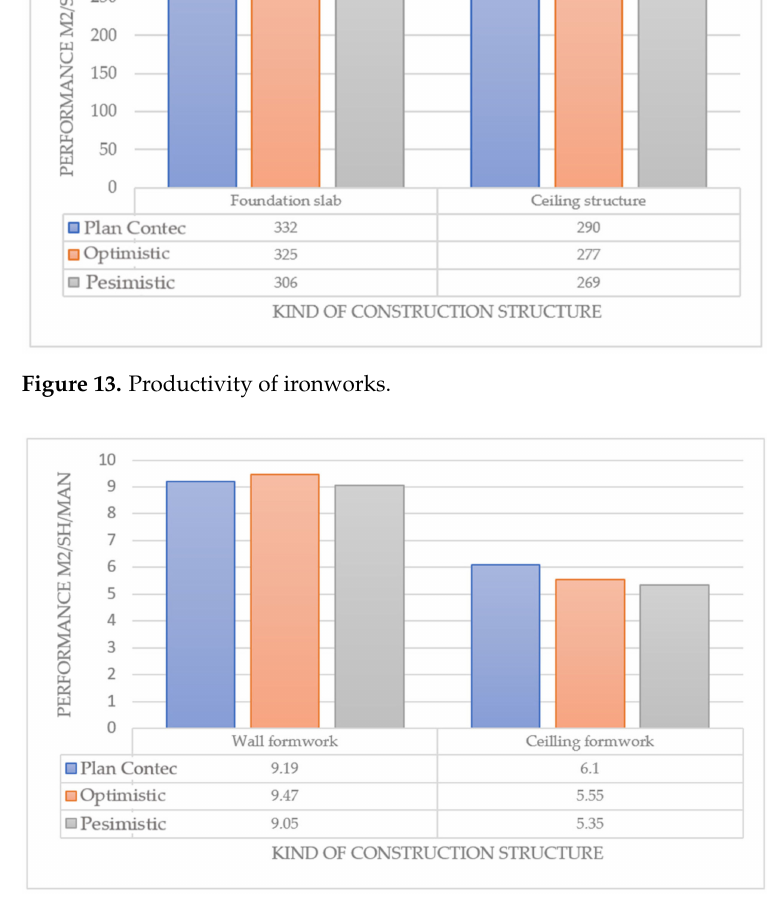
Figure 14. Productivity of